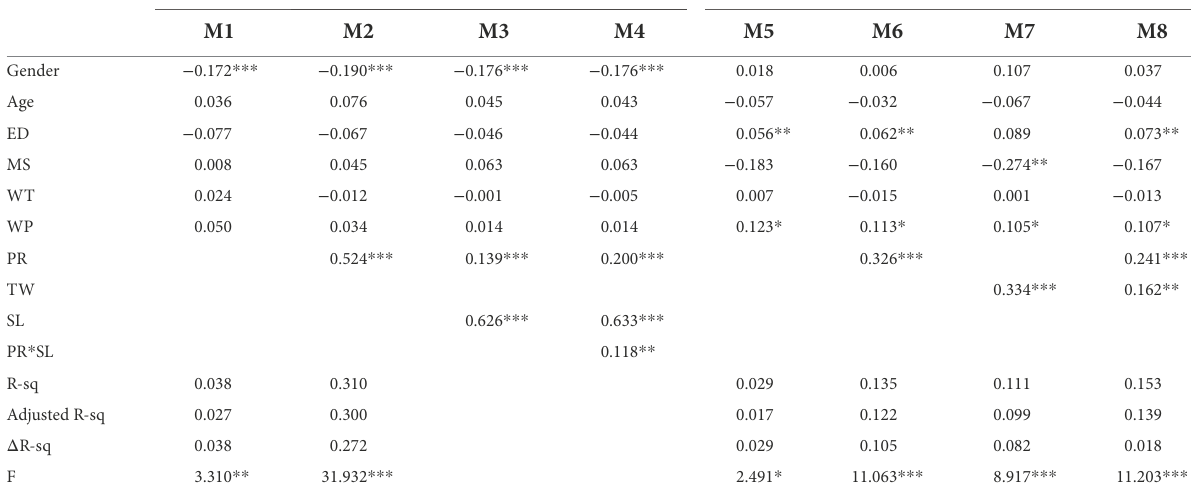
TABLE 3 Hierarchical regression analysis results. Variable Thriving at work Innovative